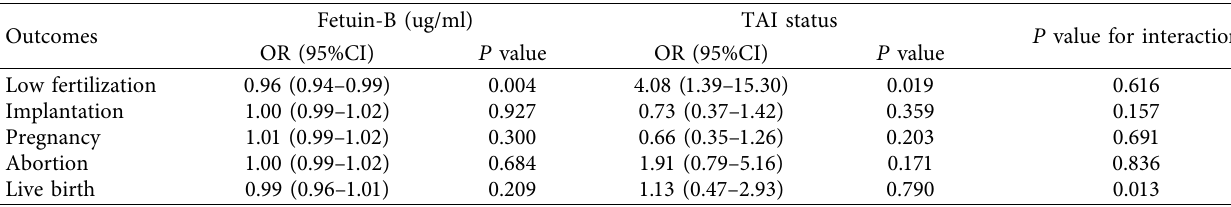
Table 3: The relationship between fetuin-B, thyroid antibodies status, and their interaction effect on pregnancy outcomes.